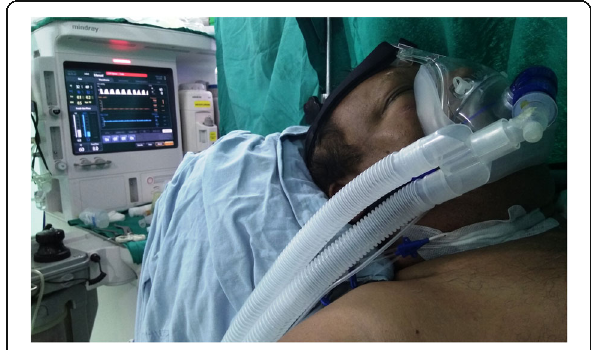
Fig. 1 Monitor showing blood pressure and heart rate list and change